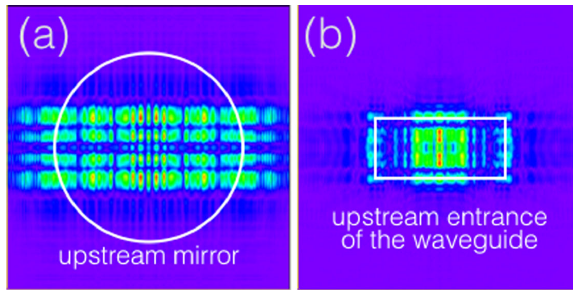
FIG. 17. Amplitude profile of the laser, for λ ¼ 20 μ m and ¼ 3 m, (a) on upstream mirror (point B in Fig. 9), and (b) on d w waveguide entrance (point C in Fig.